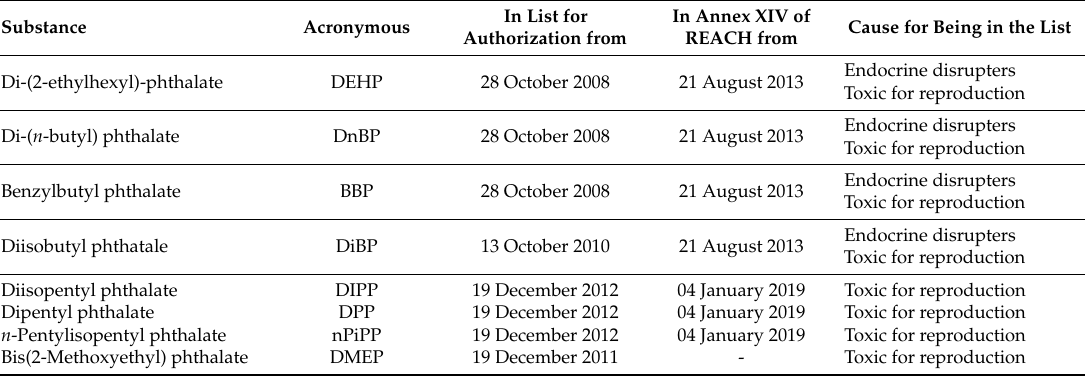
Table 1. Phthalates of “high concern” and information about the authorization due for Reg. CE